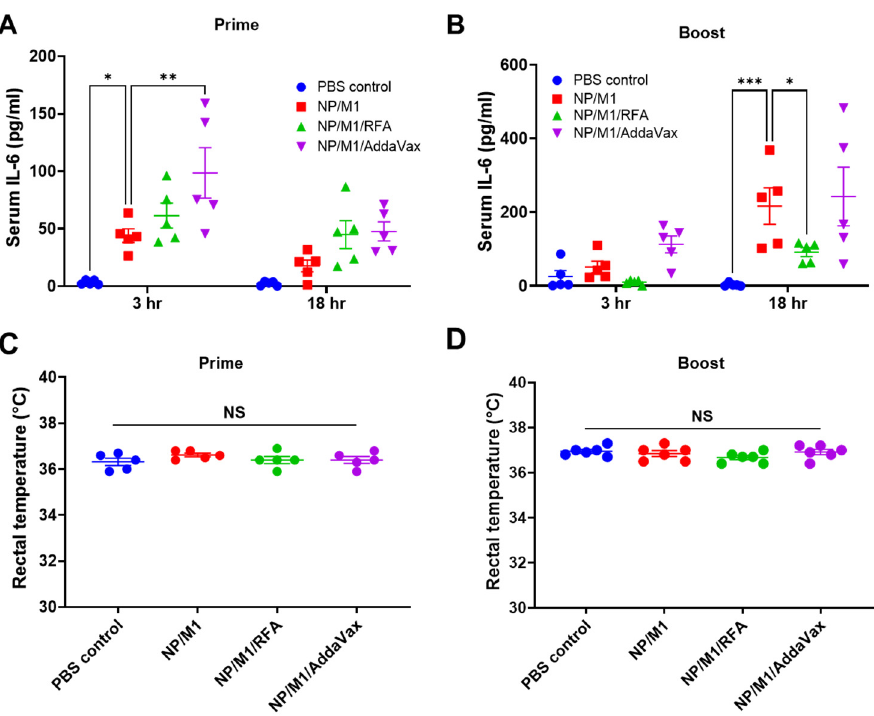
Figure 4. Systemic safety of the different immunizations. ( A , B ) Serum IL-6 levels were measured 3 and 18 hours after prime and boost immunization and are shown in ( A , B) , respectively. ( C , D ) Rectal temperature was measured 24 hours after prime and boost immunization and shown in (C , D ), respectively. Two-way ANOVA with Turkey’s multiple comparison test was used to compare differences between NP/M1 and other groups in ( A , B ). One-way ANOVA with Turkey’s multiple comparison test was used to compare differences among groups in ( C , D ). n = 5. *, p < 0.05; **, p < 0.01; ***, p < 0.001. NS, not significant.